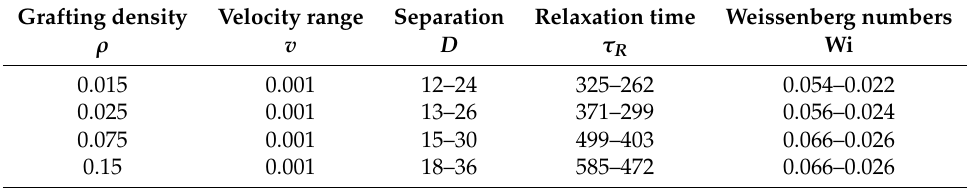
Table 1. Simulation parameters for the separation-dependency studies. To calculate a Weissenberg number Wi = 2 τ R v / D at different grafting densities and velocities, we employ the empirical